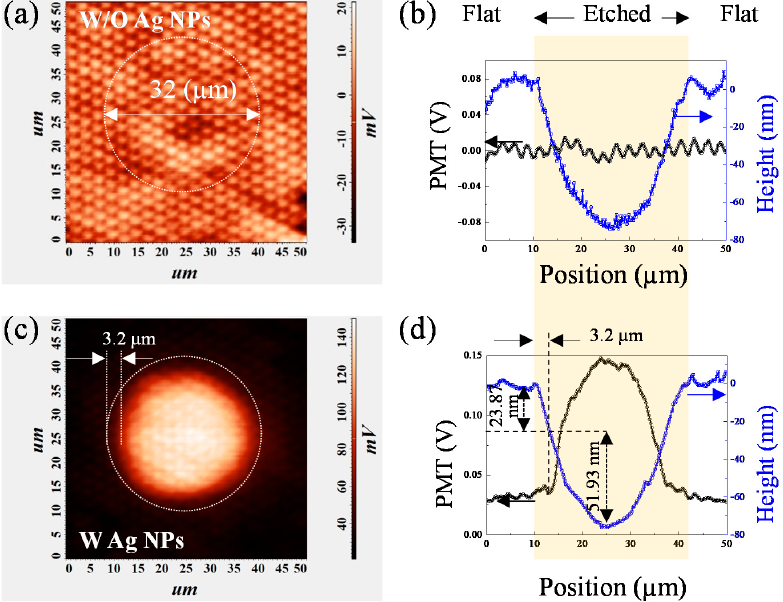
Figure 5. ( a ) The near-field PL mapping and ( b ) the PL and height profiles of cross sections through the center of the microcave of sample 3 without Ag NPs; ( c ) The near-field PL mapping and ( d ) the PL and height profiles of cross sections through the center of the microcave of sample 4 with Ag NPs.